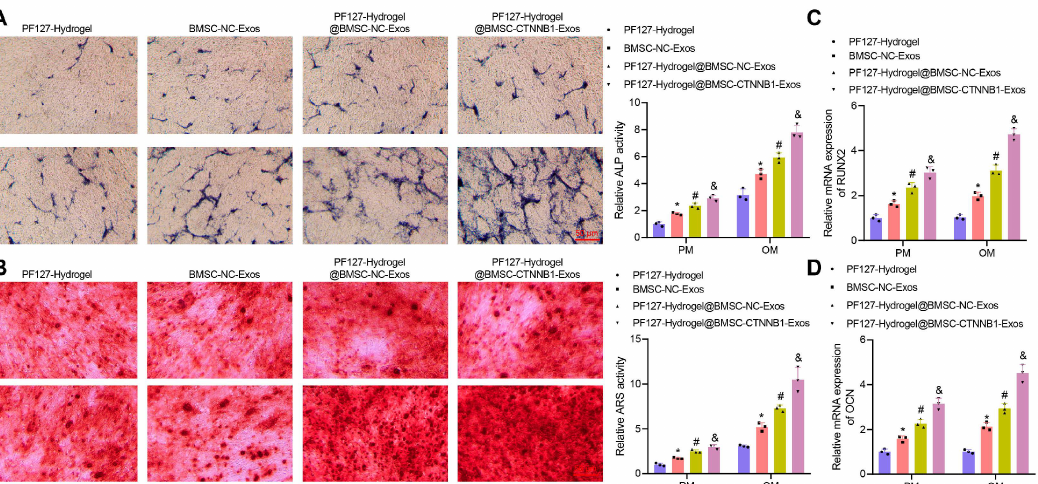
Figure 5. Effects of the PF127 hydrogel-loaded BMSC-CTNNB1-Exos on the osteogenic differentiation of the BMSCs. ( A ) ALP staining and quantitative results of BMSCs cultured with PM and OM